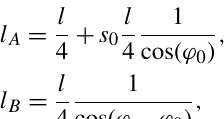
Figure 2. Model of the sensor switch of Fig. 1 without axial force, (a) setup, (b) bending beam partially coated with a hydrogel layer, (c) deflected sensor due to relative humidity changes, and (d) corre- sponding mechanical model. Shown is half of the sensor due to sym- metry reasons (left: rigid clamping, right: vertically deflectable edge of the boss structure). n B , n P torsional compliance of the bending beam with and without hydrogel, respectively, l length, l B length of the hydrogel-covered part, s deflection, ϕ angle of deflection at the transition point between the hydrogel-coated and the uncoated part, M RH torsional moment due to the hydrogel swelling, b width, h thickness. Indices: 1 substrate (silicon, steel), 2 hydrogel, p sub- strate, b